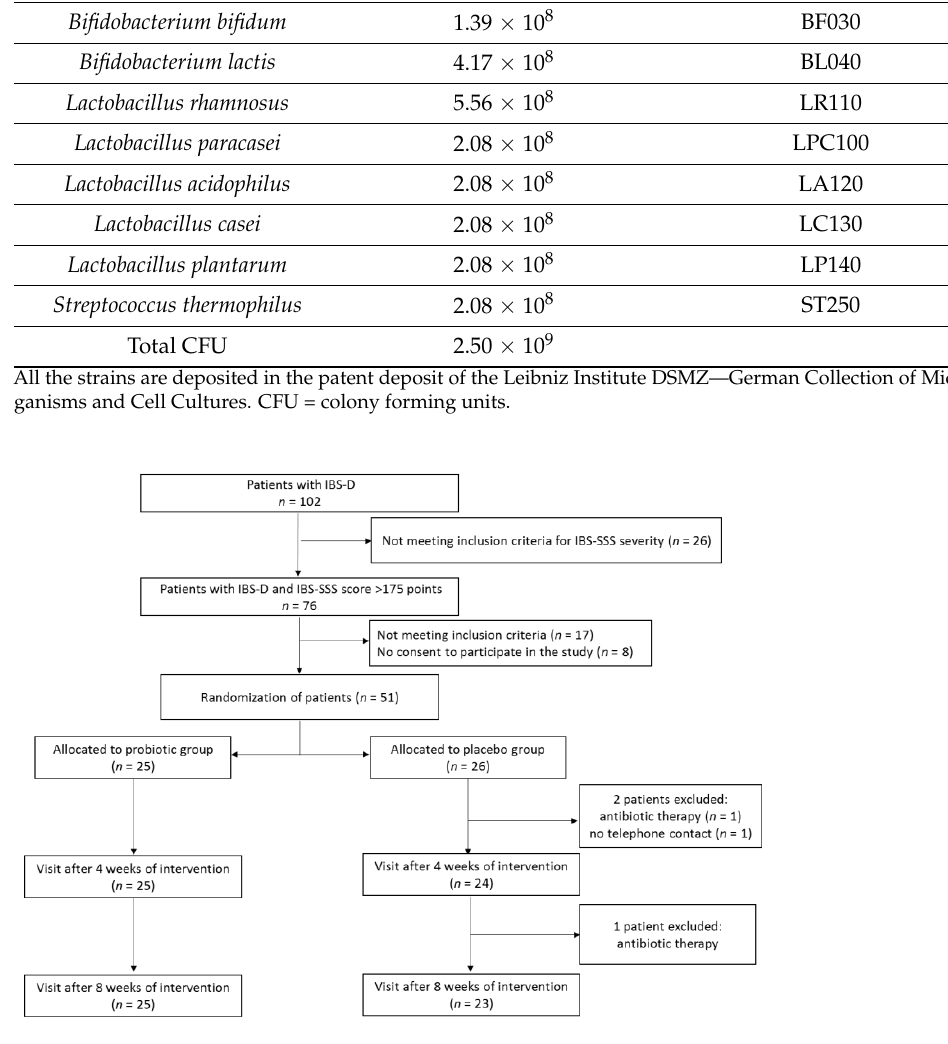
Figure 1 . Study protocol flowchart. Figure 1. Study protocol